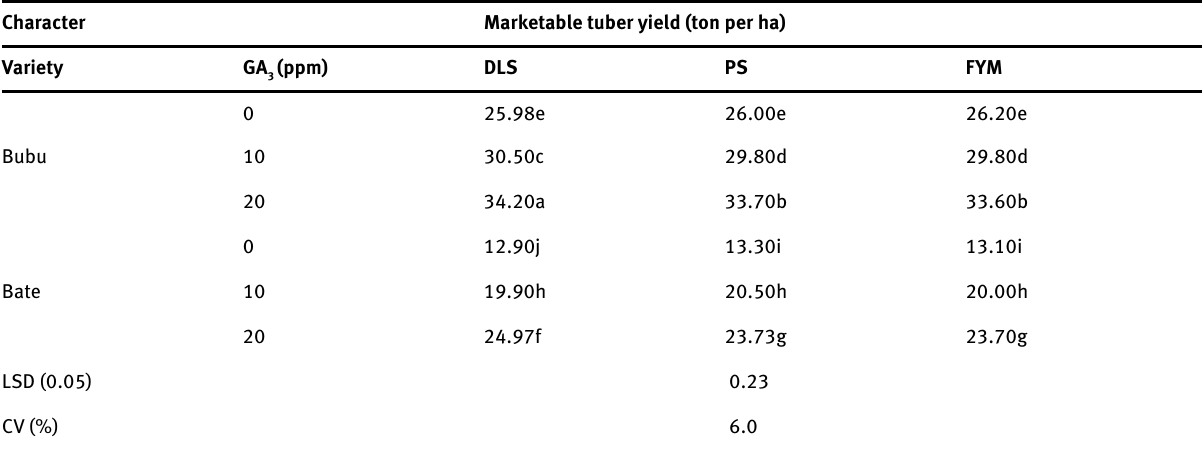
Means in rows and columns with similar letter(s) are not significantly different. DLS-Diffused light store, PS-Pit store, FYM-Farm-yard manure, LSD (0.05)-List significant difference at 0.05 probability level, CV (%)-Coefficient of variation in percent application on specific gravity, dry matter content, and total starch content of potato varieties grown in Table 7: Effect of variety and GA 3 Ethiopia Quality trait